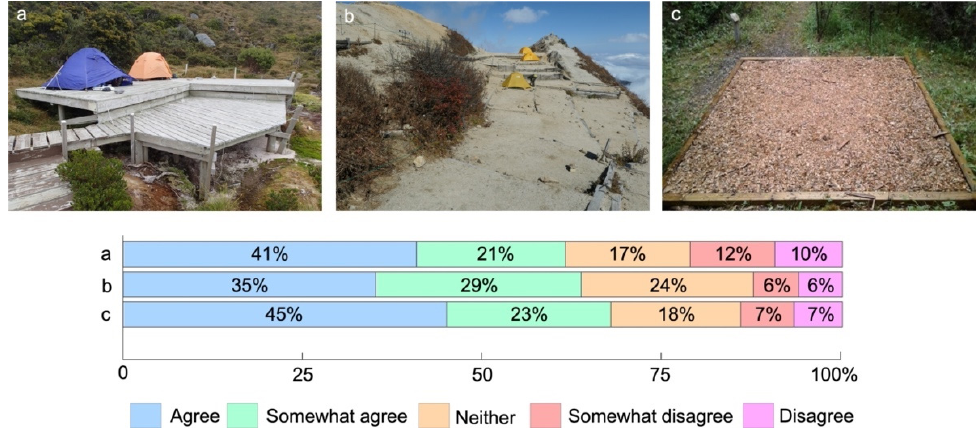
Figure 7. Perspectives of Daisetsuzan National Park’s users regarding the introduction of platforms ( a ) and tent pads ( b , c ) (n = 189). Photographs ( a – c ) were shown to respondents during the questionnaire survey. The photographs used were obtained from the following sources: ( a ): Tasmanian Wilderness, Australia ([7]), ( b ): Enzanso campground in Chubusangaku National Park (taken by the authors), ( c ): Lost Horse Creek campground, Banff National Park, Canada (https://reservation.pc.gc.ca/